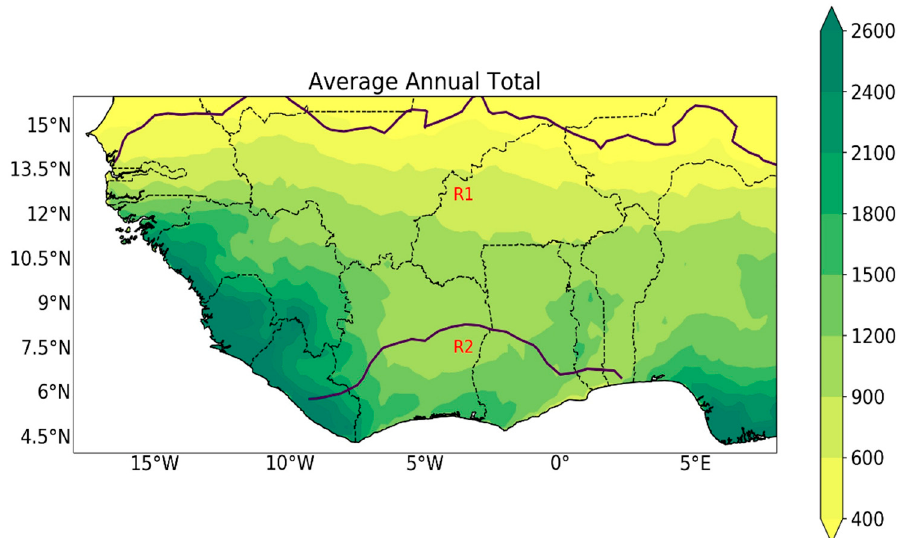
Figure 1. Annual average precipitation (mm) from 1981 to 2014 from CHIRPS data. Region R1 indicates unimodal regions, while region R2 represents areas defined as bimodal regions for each grid point in CHIRPS based on the ratio of the amplitudes of the first two harmonics. A ratio greater than 0.75 indicated a bimodal point and a ratio less than 0.75 indicated a point with a unimodal regime.